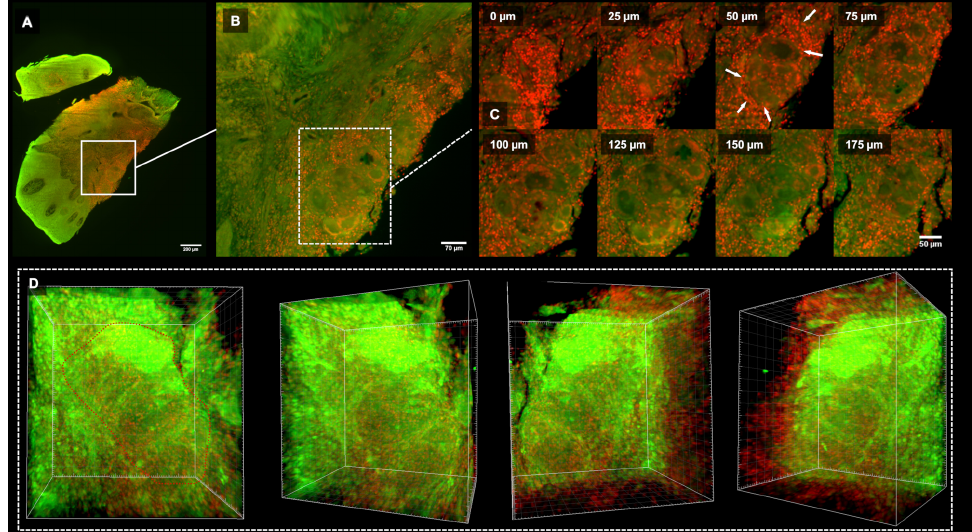
Figure 3. Gingival OFG 3D microscopy. ( A ): Low magnification LSFM acquisition. ( B ): Granuloma focus. ( C ): Granuloma 175 µm depth series acquisition. Note the leucocytes cells surrounding the granuloma edges (white arrows). ( D ): Sequential 3D frames emphasized the granuloma multilocular oval-shape (Supplementary Movie